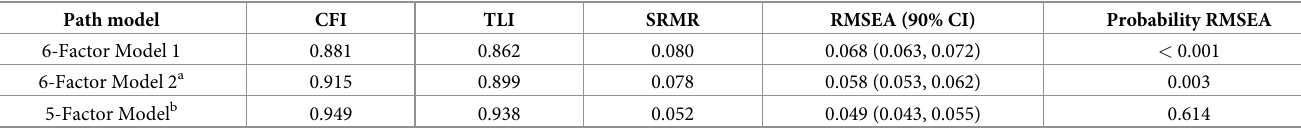
Table 2. Summary for six-factor model fit